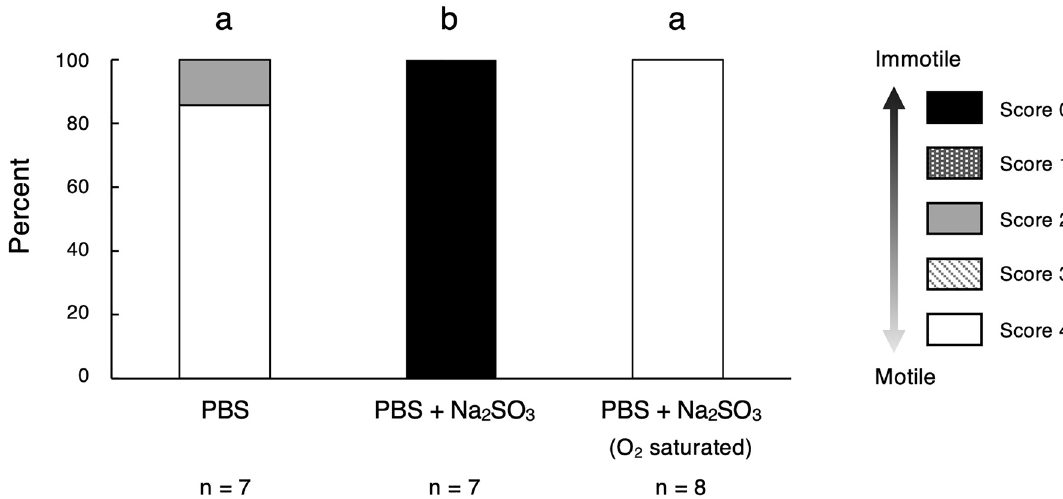
Figure 2. Sperm motility in the aerobic PBS control (21% O 2 ), the anoxic PBS condition (0% O 2 ) created by adding sodium sulfite and an oxygen-saturated sodium sulfite solution in PBS (21% O 2 ). Different alphabetical symbols indicate statistical significance at p < 0.05, based on Tukey’s post-hoc